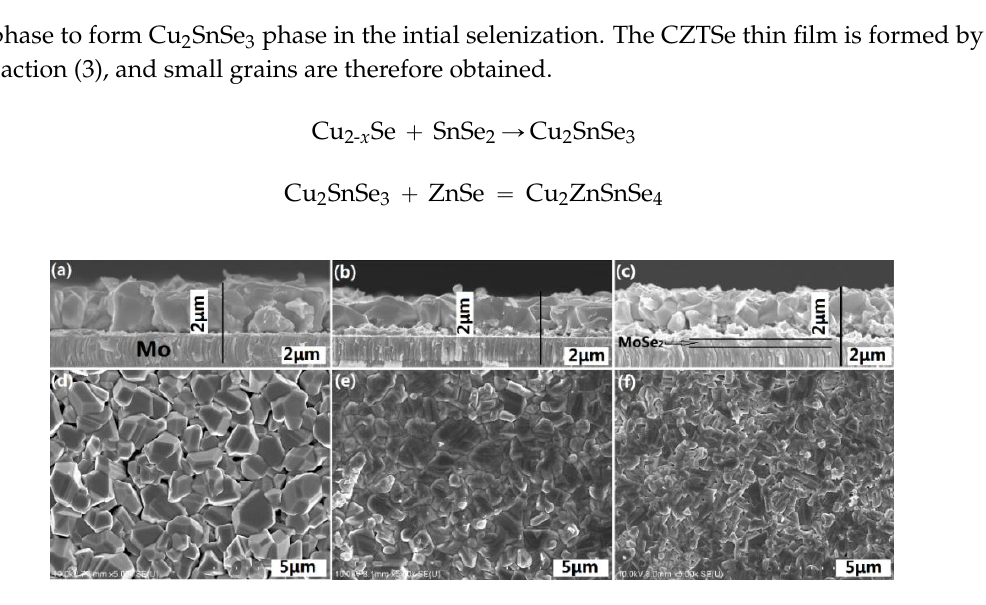
Figure 5. The surface morphology and cross-sectional SEM images of the CZTSe films that wereprepared bythe selenization of the precursor with samples ( a , d ) A1;( b , e ) A2; and ( c , f ) A3.